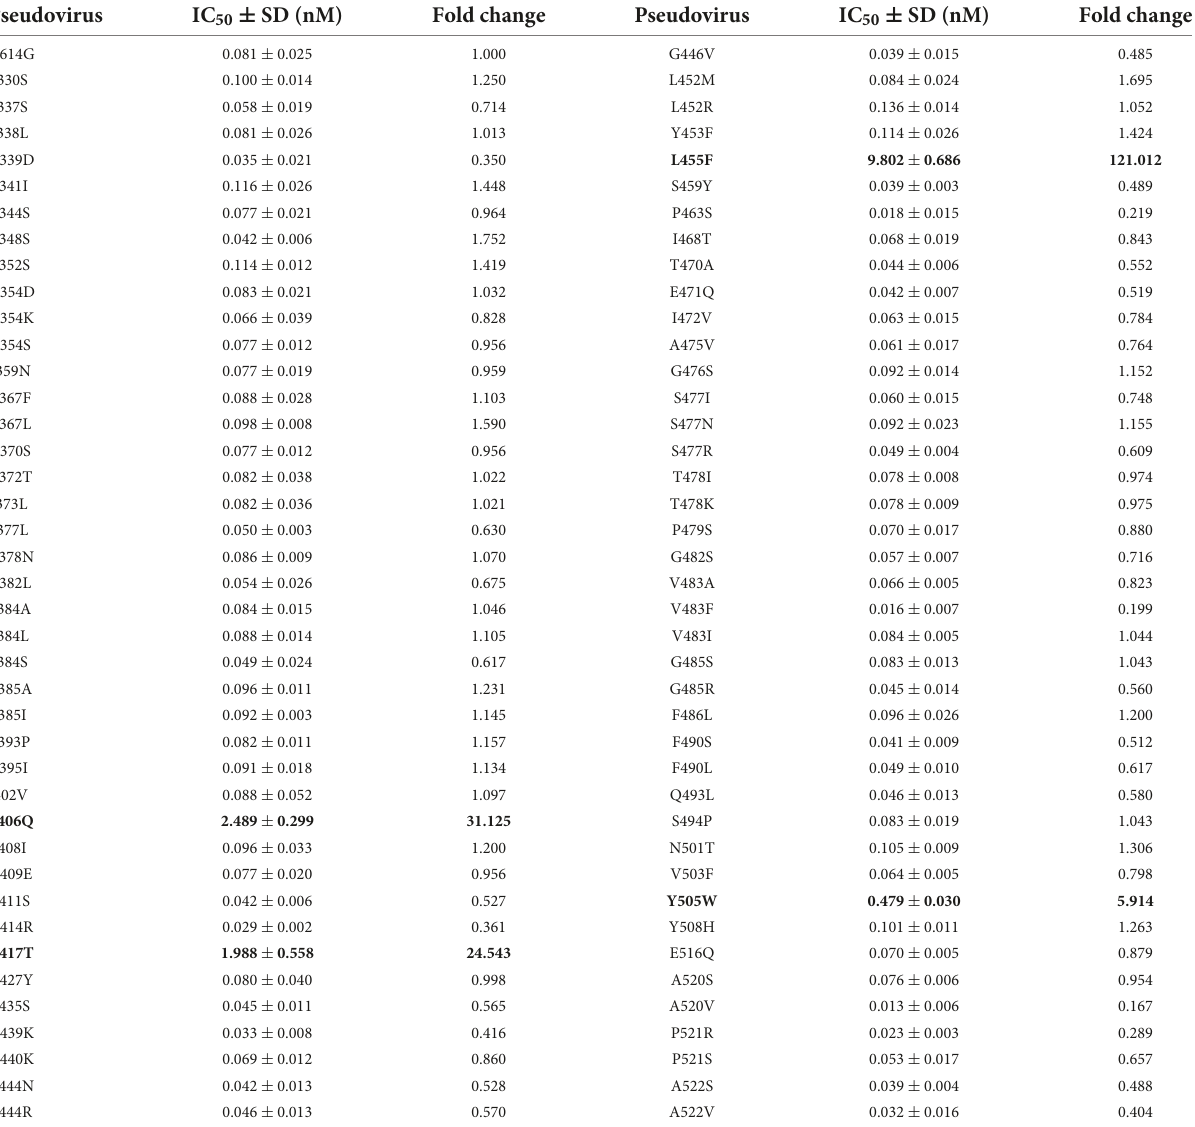
TABLE 2 Characterization of naturally occuring RBD mutations that mediate LCB1 resistance.